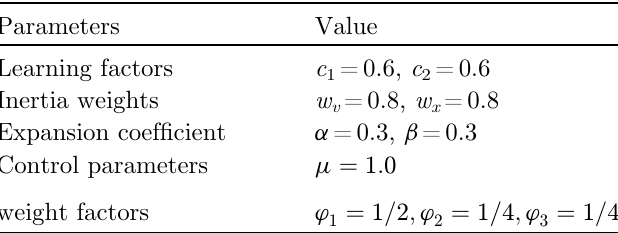
Table 2. Particle swarm model parameters.